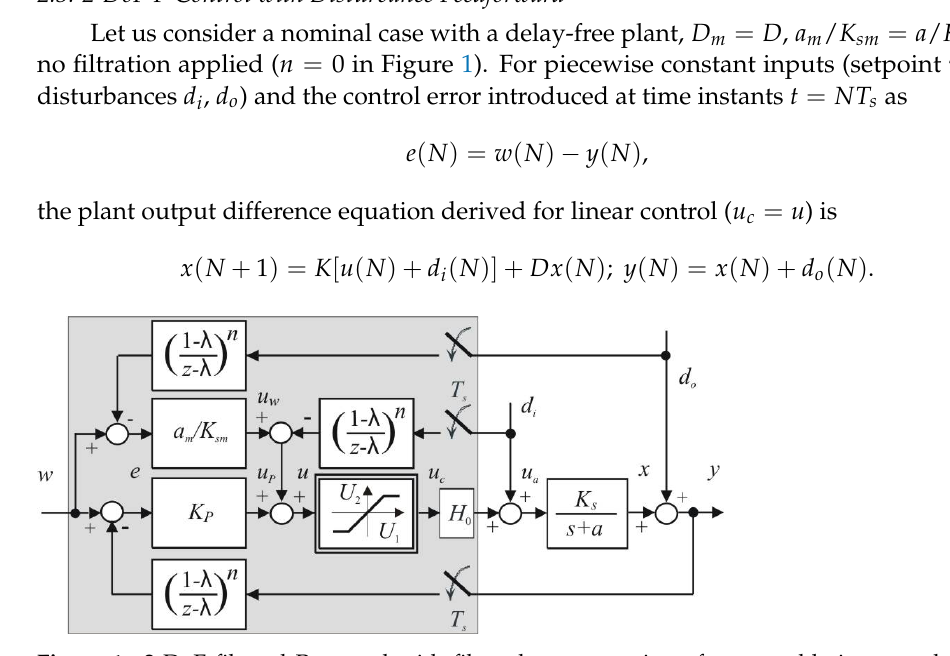
Figure 1. 2-DoF filtered P control with filtered compensation of measurable input and output disturbances d i and d o , H o = zero-order